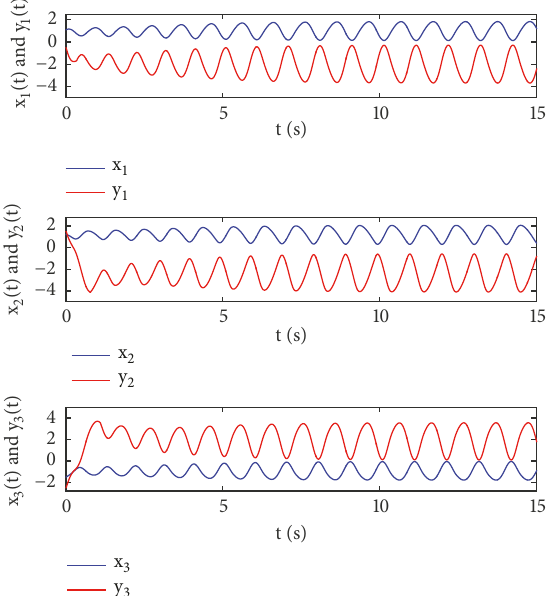
Figure 8: State trajectories of master-slave systems with 𝜉 = -2.